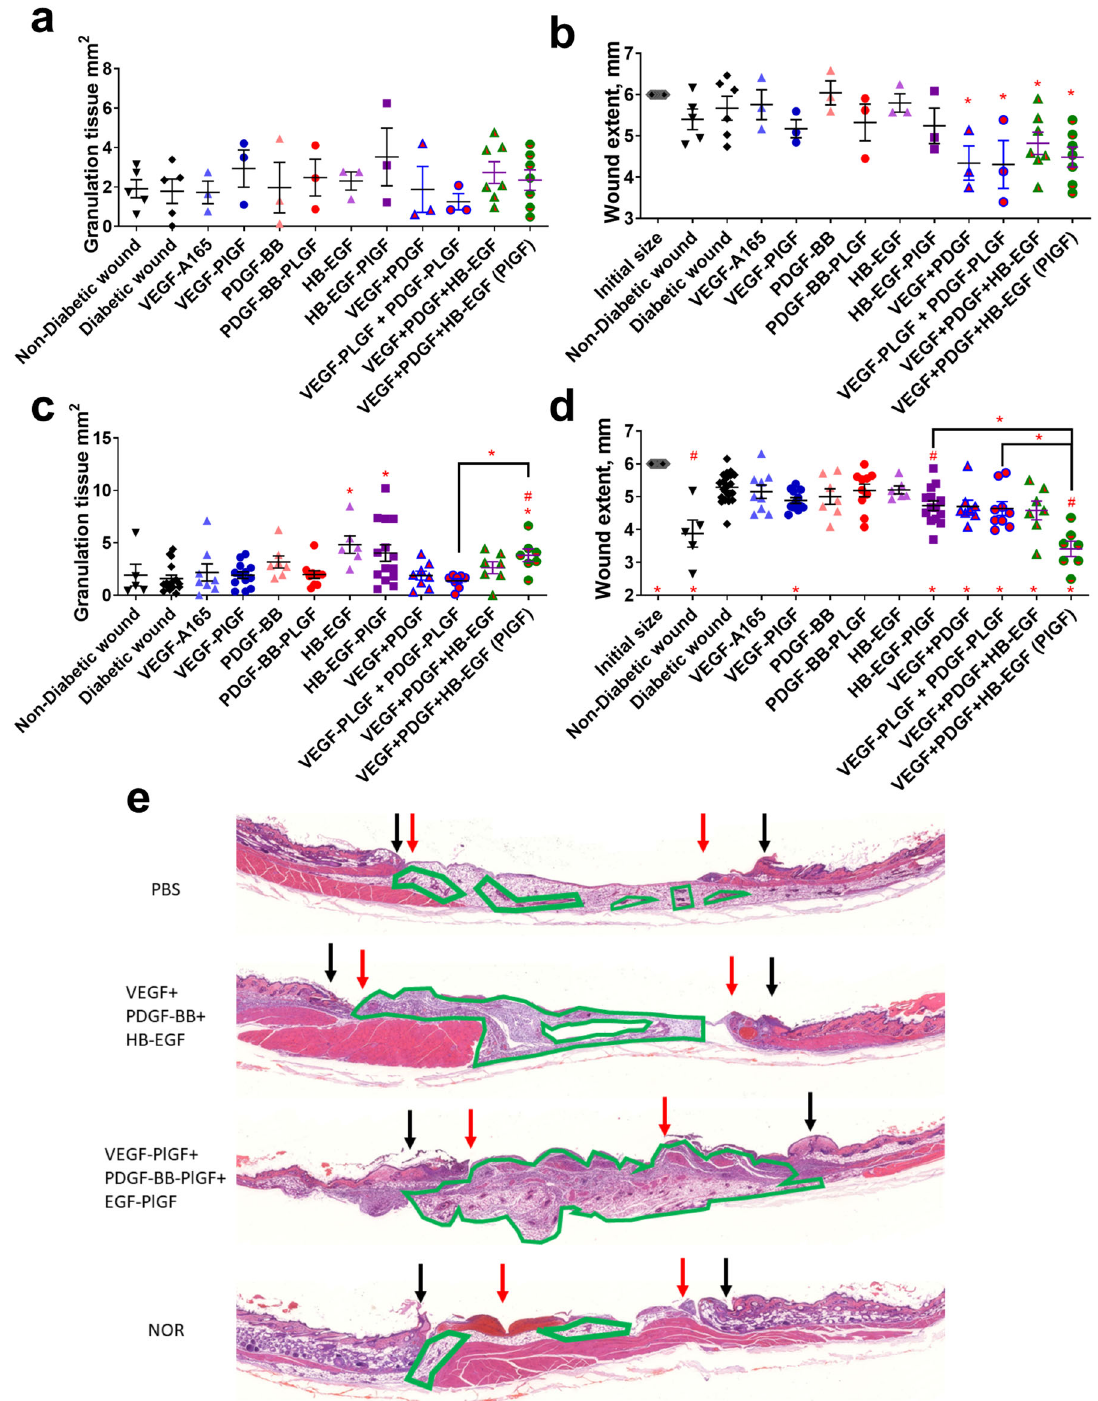
Fig. 1 The triple therapy of VEGF-PlGF-2 123 – 144 , PDGF-BB-PlGF-2 123 – 144 , and HB-EGF-PlGF-2 123 – 144 improves wound healing in the T1D NOD mouse model. Given as measured by increased granulation-tissue formation ( a , c ) and wound extent (diameter of unhealed wound normalized to the known length of the resection biopsy punch (12 mm) to account for folding or contracture of wound tissue ( b , d )). Time points assayed are 3 days ( a , b ) and 7 days ( c , d ). For wound extent, smaller numbers indicate more healing. e Representative images of healed wounds from 7 days, stained with hematoxylin and eosin. Black arrows indicate initial wound extent, red arrows indicate healed extent. Scale bar is 1 mm. n ranges from 3 to 20. * Denotes comparison to the diabetic wound. # Denotes a comparison between untreated NOD wound and untreated NOR wound, and the WT GF(s) are compared to their counterpart -PLGF-2 123 – 144 variant(s), e.g., VEGF vs VEGF- PlGF-2 123 – 144 . * p < 0.05, p < 0.01, p < 0.001, ANOVA + Student ’ s t -test for post hoc for wound extent, Kruskal-Wallis + Mann-Whitney post hoc test for granulation tissue. # p < 0.05, p < 0.01, p < 0.001, Mann-Whitney for granulation tissue, Student ’ s t -test for wound extent. Student ’ s t -test for comparison between